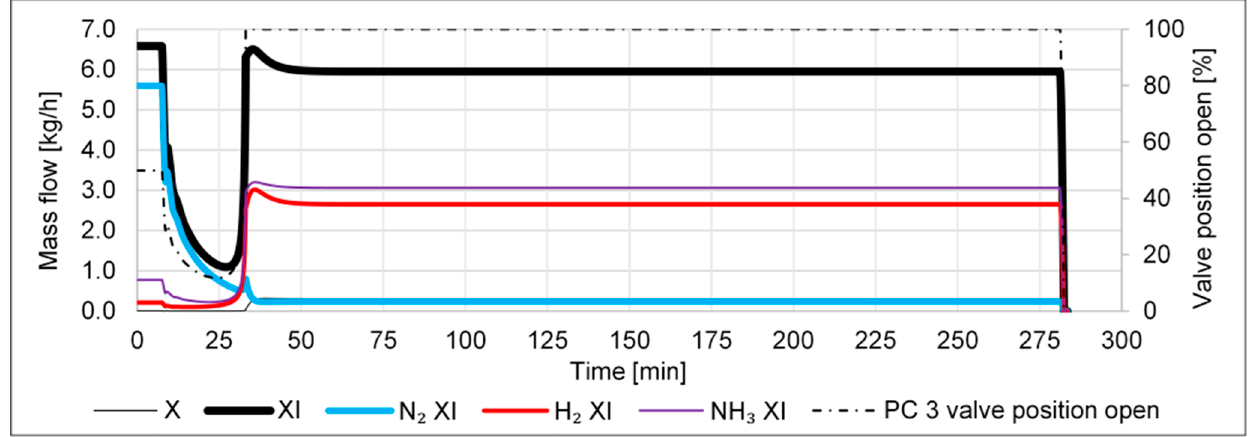
Figure 8. Further mass flows (left vertical axis) and position of the recycle valve (right vertical axis) of scenario (c).